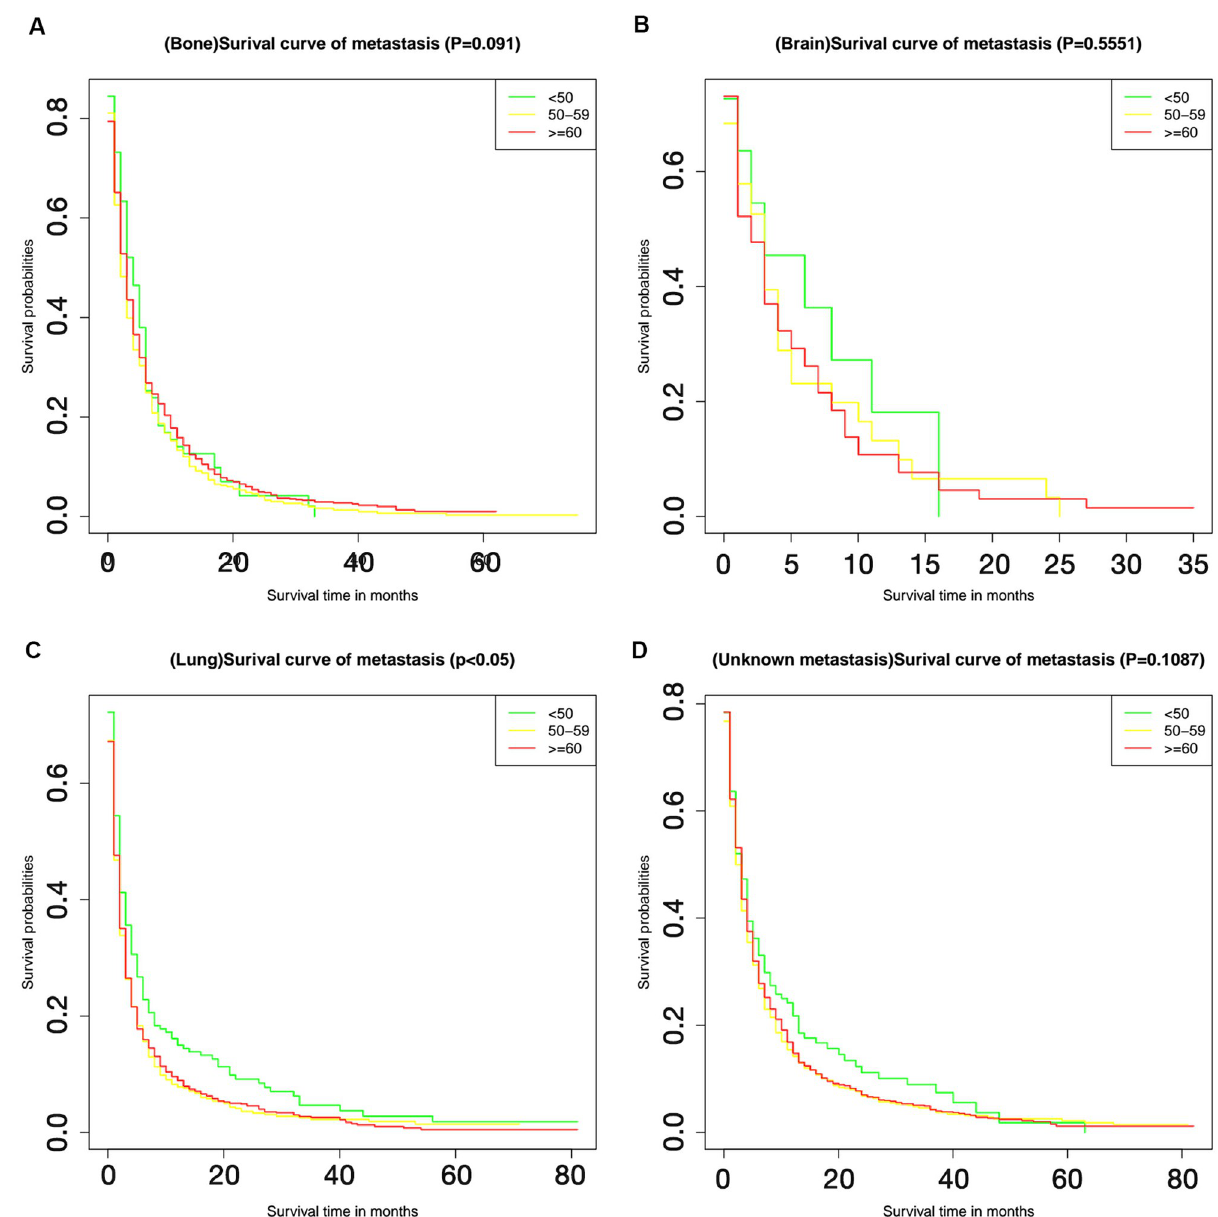
Fig 6. Kaplan-Meier curves for different metastatic sites. The Kaplan-Meier survival curves show the differences on survival probabilities among < 50 years, 50–59 years and � 60 years patients with bone metastasis (A), brain metastasis (B), lung metastasis (C) and unknown metastasis